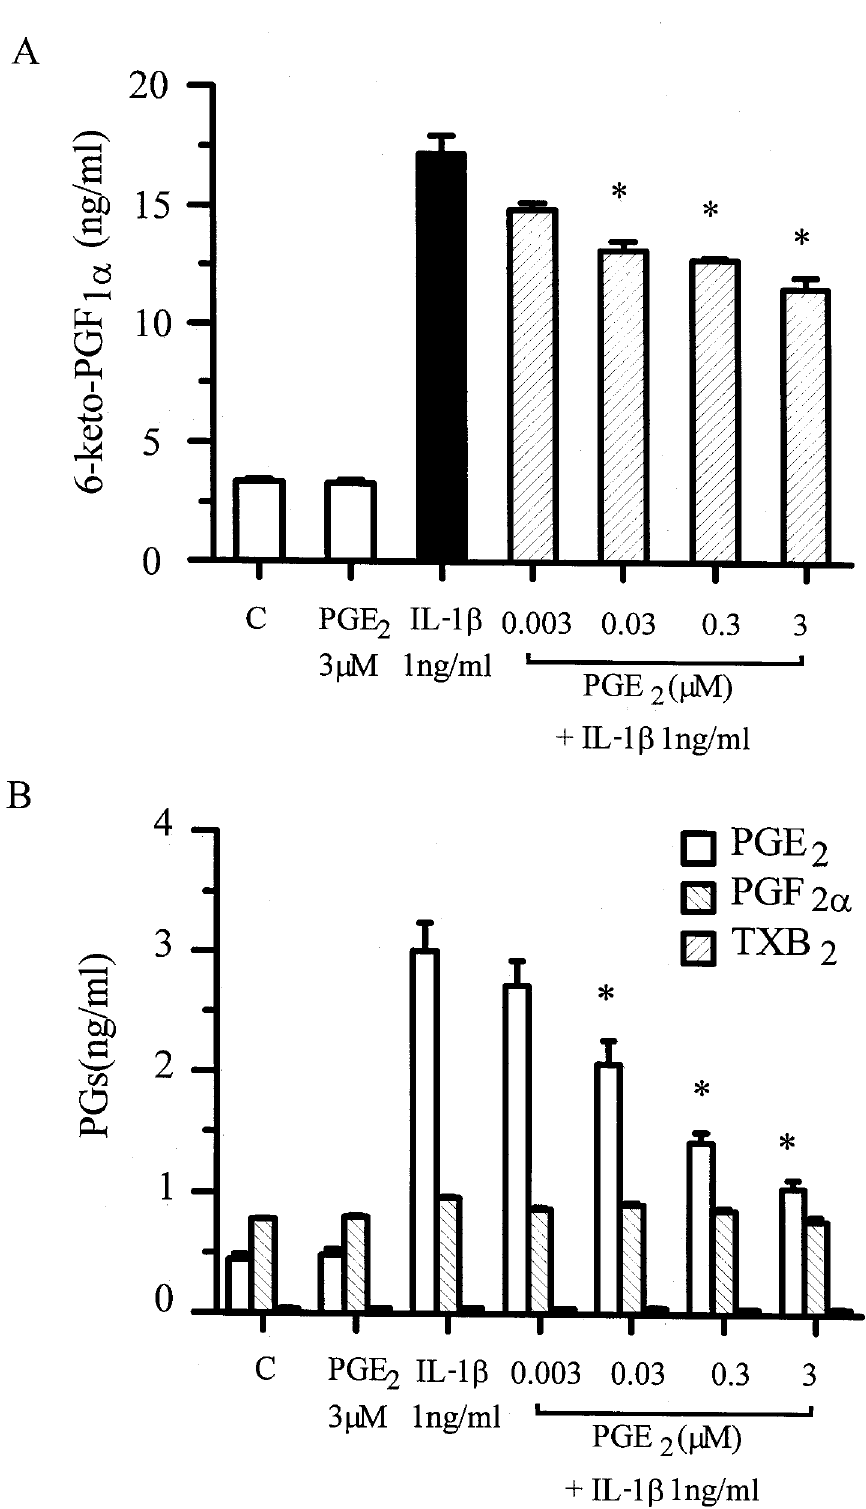
FIG. 2. The effects of PGE 2 (0.003, 0.03, 0.3 or 3 m M) on COX activity in IL-1 b (1ng/ml) treated HUVEC. COX activity was measured by the formation of 6-keto-PGF 1 (panel A), PGE 2 (panel B), PGF 2 (panel B) and TXB 2 (panel B) in the presence of a a exogenous arachidonic acid (10 m M; 10min). Data are expressed as mean±SEM of 12 determinations from at least four separate experimental days. * P < 0.05 when compared to IL-1 b treated HUVEC at